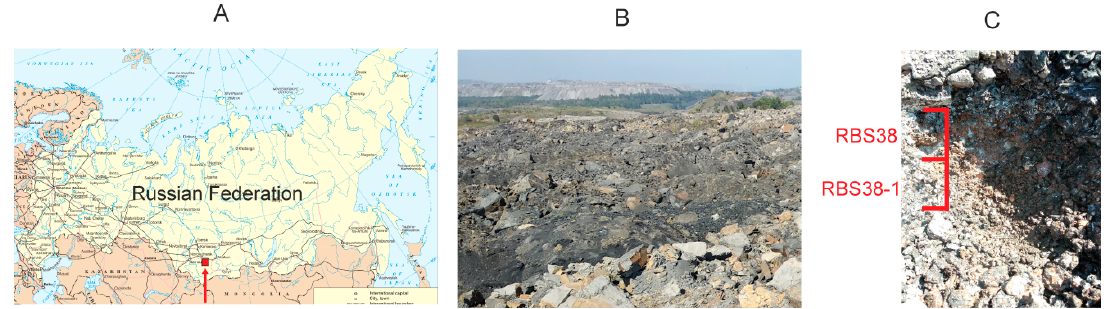
Figure 1. The site of underground coal fire studied in the work. ( A ) Location map. The red rectangle shows the location of the study area. ( B ) General view of the area. ( C ) Sampling site.